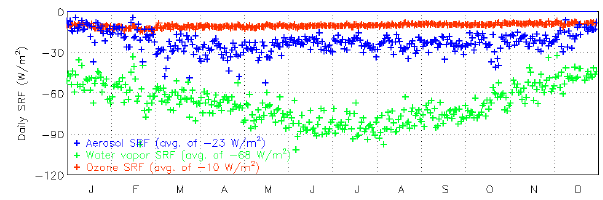
Figure 10. Daily surface radiative forcing due to aerosols (blue), water vapor (green), and ozone (red) in 2011 resulting from averag- ing over the nine ground stations considered in this